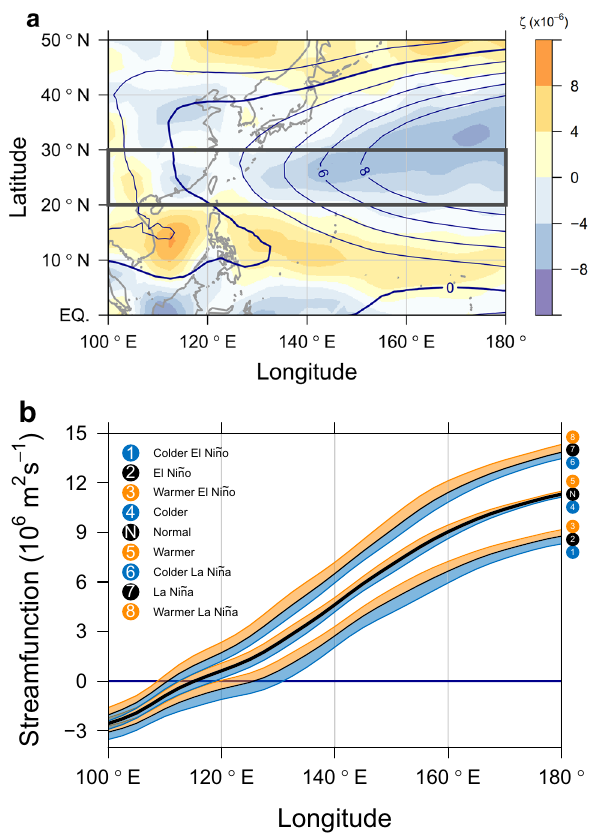
Figure 3. Geographical patterns of streamfunction. ( a ) Mean fields of streamfunction ( ψ ) and vorticity ( ζ ), and ( b ) the sequential patterns of ψ corresponding to the eight modes of variability. All values are originally calculated in a global domain and zoomed in for the western North Pacific. In (a), local vorticities are shaded following the color legend on the right side, and streamlines are contoured at 10 dark blue line indicates a streamline with zero values. The lines in (b) show each longitudinal distribution of ψ averaged over the latitudes between 20 ◦ and 30 ◦ N as denoted by a black rectangle in (a). The thick black line represents the zonal distribution of the mean field as a reference, and the two thin black lines show the ENSO anomalies. Orange and blue shades represent the warm and cold anomalies, respectively. It is found that the patterns are sequentially continuous showing a geographical spectrum, which implies the narrowing region for tropical convections as the chain number moves from 1 to